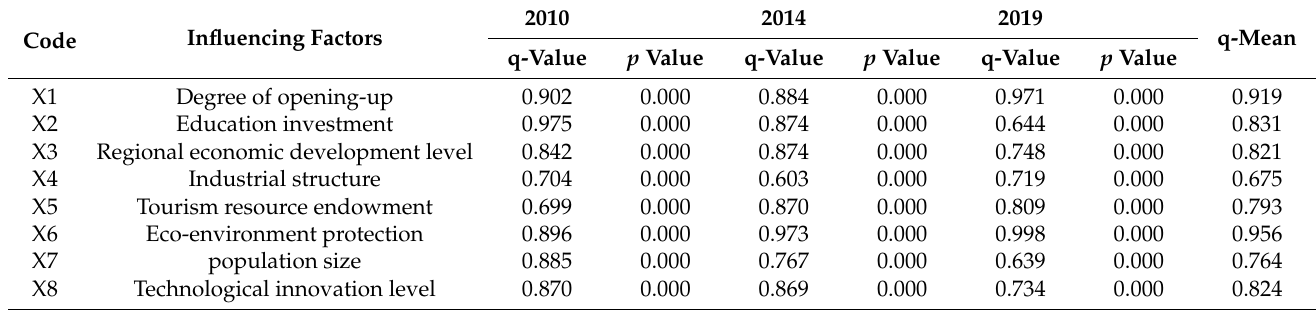
Table 5. The impact of various indicators on the CCD of the TEE system in